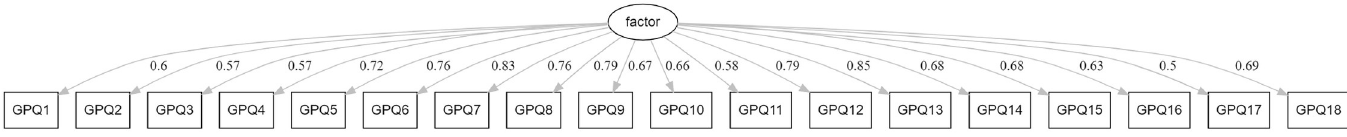
Fig 1. Standardized solution of the GPQ18 one-factor model in a Polish